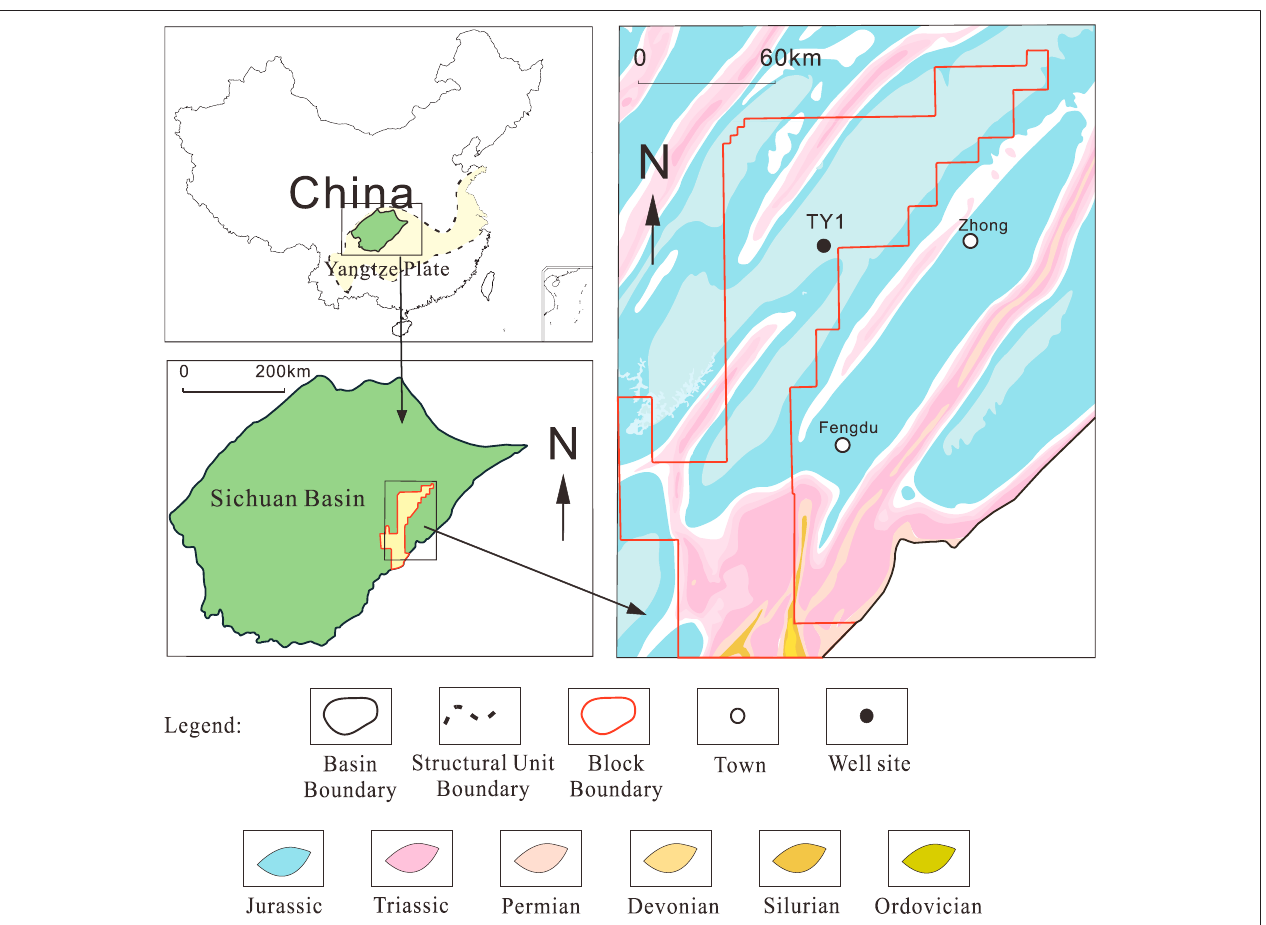
FIGURE 1 | Block location of the southeastern Sichuan Basin in southern China and distribution of the well TY1. Modi fi ed from references (Guo et al., 2016; Guo et al., 2017; Liu W. et al., 2021; Wei et al., 2021).